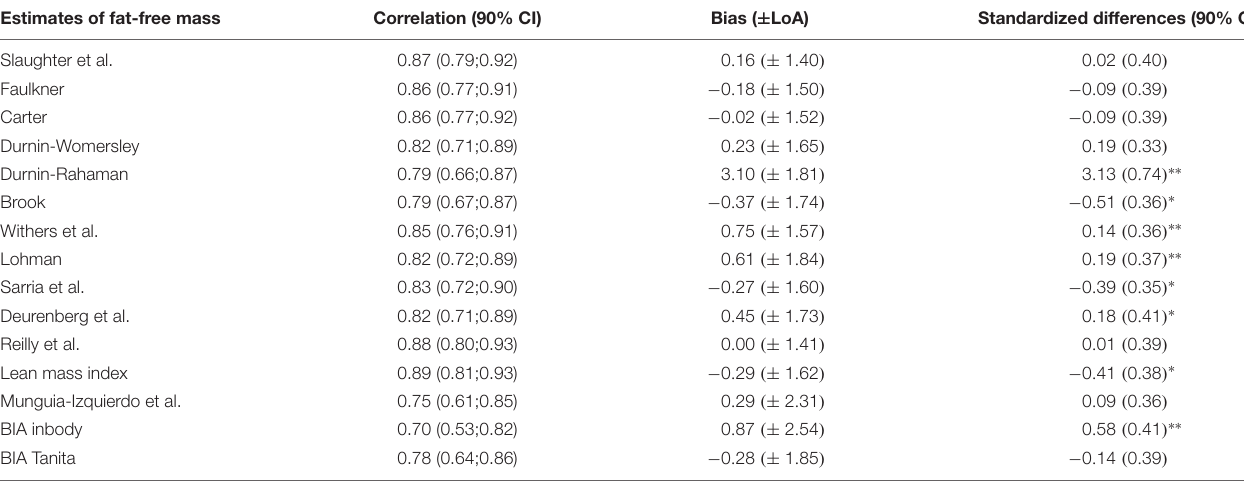
TABLE 3 | Correlations, biases, limits of agreement, and standardized differences between changes in FFM with DXA and other practical estimates in elite youth soccer players ( n = 40). Estimates of fat-free mass Slaughter et